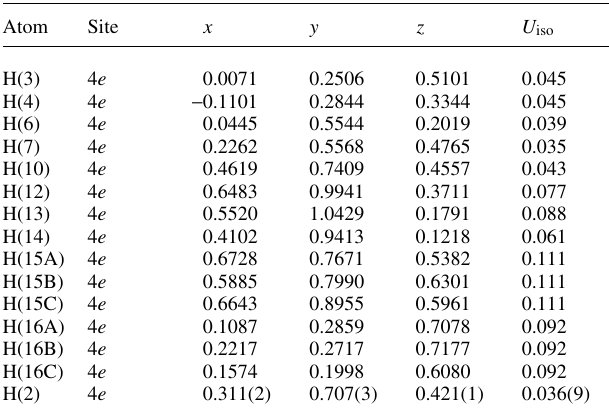
Table 2. Atomic coordinates and displacement parameters (in Å 2 )